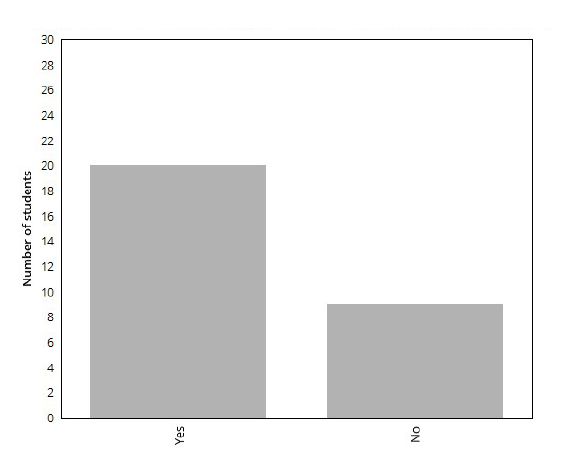
methodology easy to